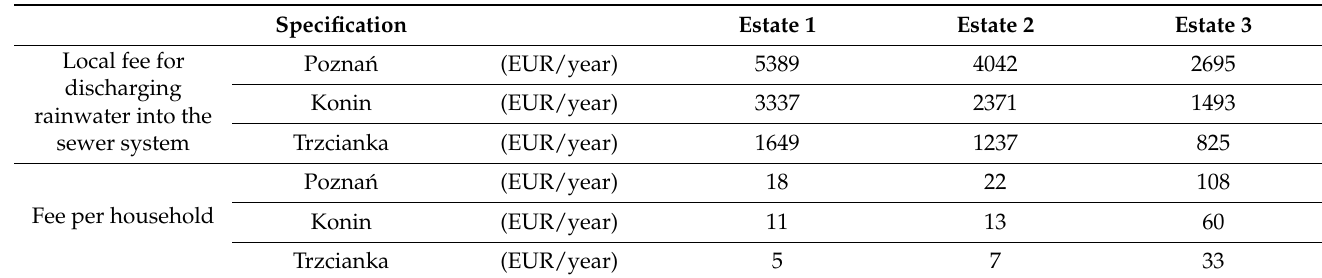
Table 12. Fees for rainwater discharge in the analyzed